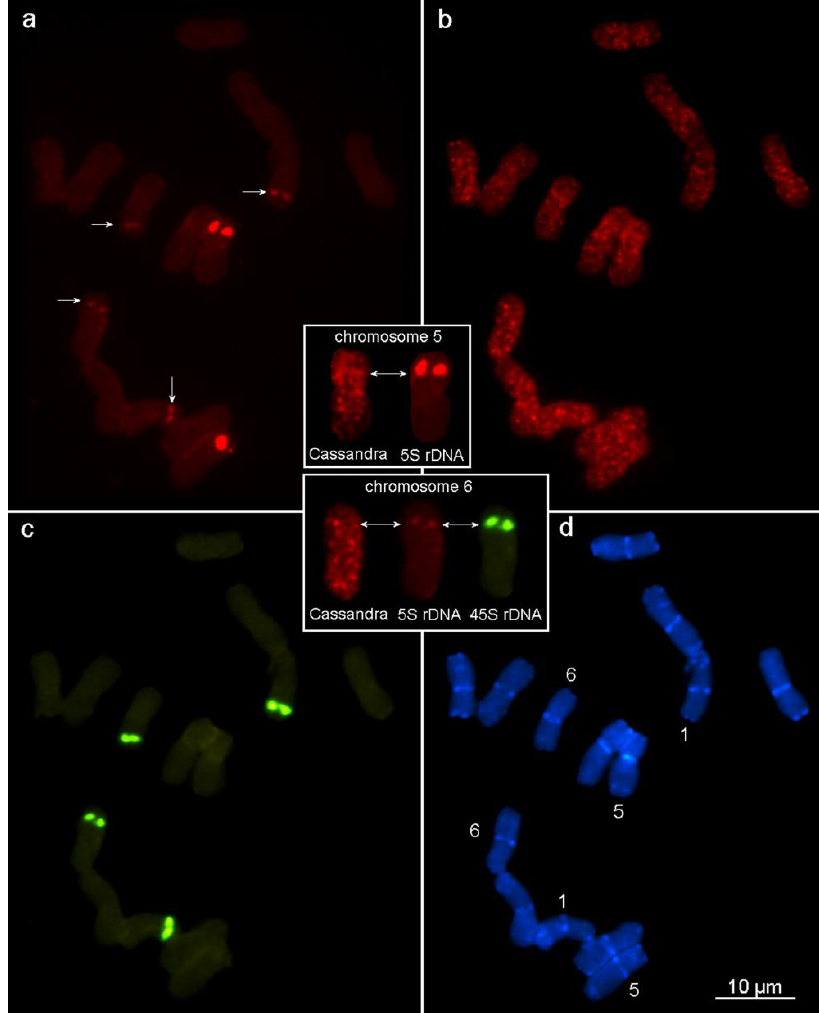
Figure 5. Chromosomal distribution of Cassandra in the Aegilops speltoides Tauch. (2 n = 2 x = 14) genome. Fluorescent in situ hybridization (FISH) of ( a ) 5S rDNA labeled in red (additional 5S rDNA clusters on chromosomes 1 and 6 are shown with arrows), ( b ) Cassandra retrotransposon (in red), ( c ) 45S rDNA (in green) on metaphase chromosomes of Ae. speltoides , and ( d ) differential staining with DAPI (in blue). Clusters of Cassandra elements have been distinctly observed in euchromatin ( b ), while in distal/terminal heterochromatic regions ( d ) a strong reduction in signal occurs. Notably, distinct clusters of Cassandra elements coincide with regular 5S rDNA blocks on chromosome 5 as well as with additional blocks on chromosomes 1 and 6 that normally carry 45S rDNA gene clusters (arrows on the enlarged chromosomes 5 and